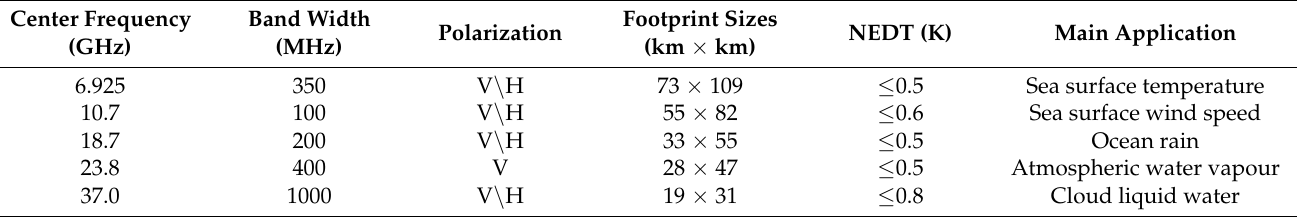
Table 1. Instrument specifications of